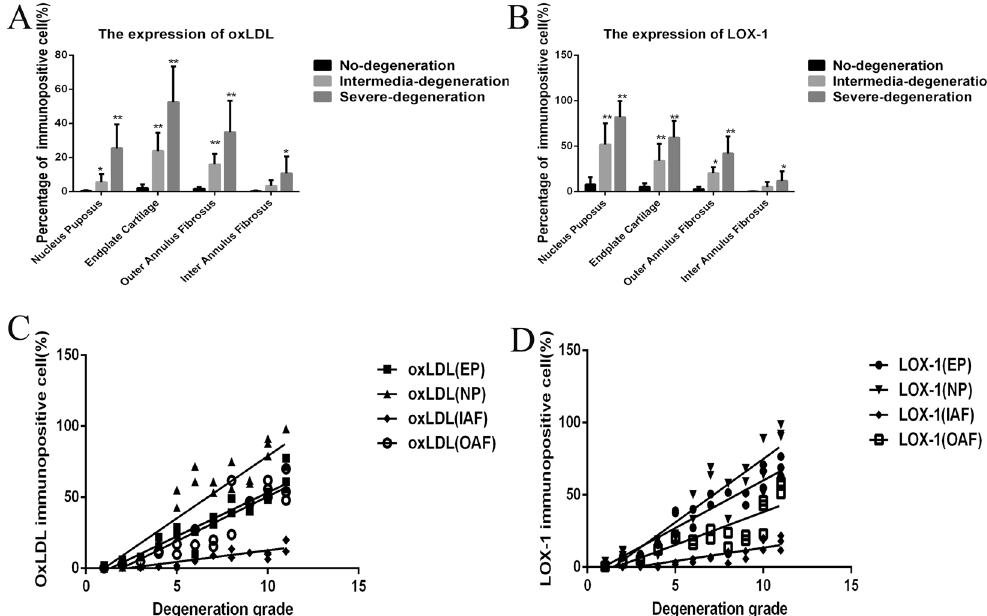
Figure 2. The percentage of cells with immunopositivity for ( A ) LOX-1, ( B ) oxLDL, according to location in the disc and grade of intervertebral disc degeneration. For oxLDL immunopositive cell. ( C ) The Correlations analysis between ox-LDL immunoreactivity and intervertebral disc degeneration score were performed. (R 2 EP = 0.91, P < 0.0001; R 2 NP = 0.83, P < 0.0001; R 2 OAF = 0.85, P < 0.0001; R 2 IAF = 0.75, P < 0.0001). ( D ) The Correlations analysis between LOX-1 and intervertebral disc degeneration score were performed (R 2 EP = 0.83, P < 0.0001; R 2 NP = 0.86, P < 0.0001; R 2 OAF = 0.76, P < 0.0001; R 2 IAF = 0.78, P < 0.0001). Data are presented as means ± SD. ( * P < 0.05, ** P <